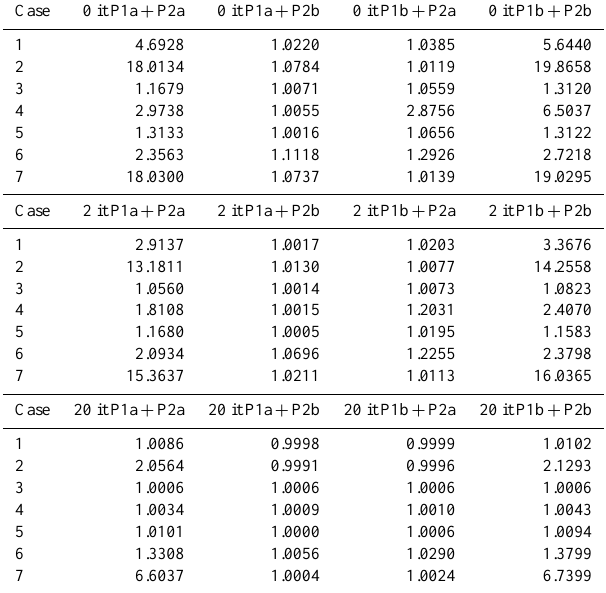
Table C4. Average error for iterative versions for the overall anal- ysis: 0, 2 and 20 iterations. The average relative error variance is based on 100000 independent